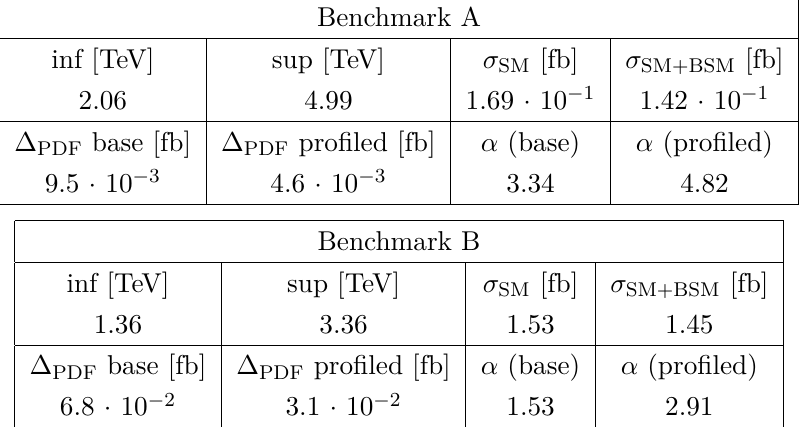
Table 3 . Integration limits for the dip region, integrated cross section for the SM background and the complete model and its PDF uncertainty with the baseline CT18NNLO PDF set [37] and the profiled PDF set using A FB + A W pseudodata as well as the significances α employing the two PDF errors for an integrated luminosity of 3000 fb − 1 for the benchmarks A and